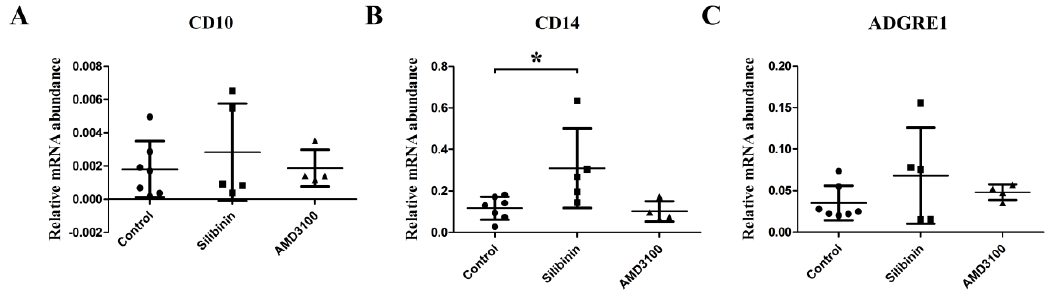
Figure 2. Comparison of gene expression levels of granulocyte and monocyte-macrophage cell